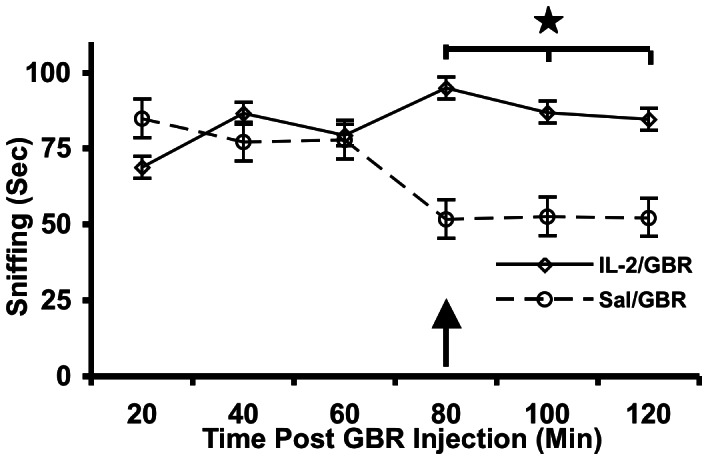
IL-2 administration in periadolescent mice increases sensitivity to GBR-induced stereotypic sniffing administered 30-days later in adulthood.Mean (± S.E.M.) activity score of GBR 12909-stimulated sniffing time. Mice received a single injection of saline or IL-2 (0.4 µg/mouse, s.c.), and were tested 30 days later with GBR 12909 (7 mg/kg, i.p.). Mice were exposed to the test cage immediately following GBR administration. Note that the effect was initially observed at 80-minutes post-injection (shown with arrow). *p<0.05.